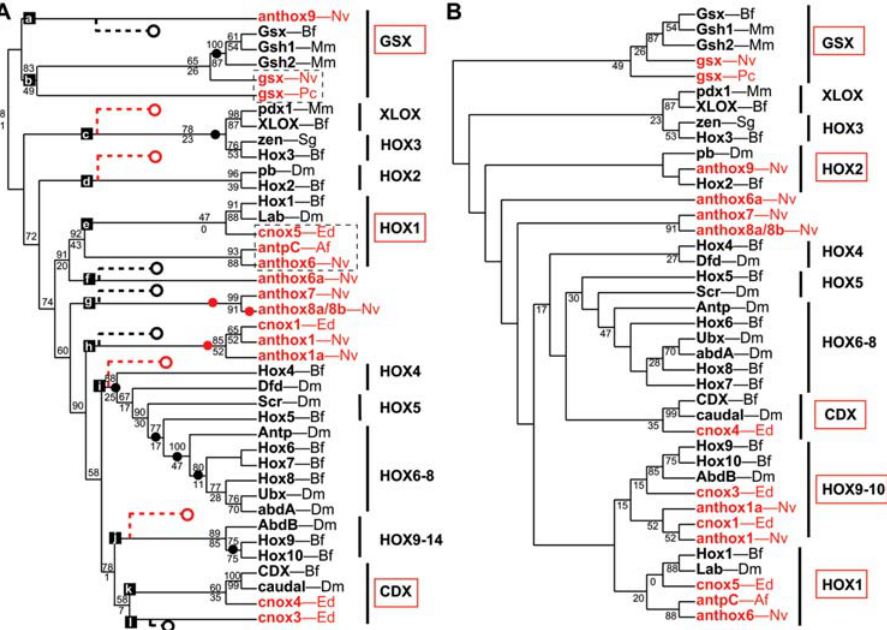
Figure 9. Re-analysis of the Kamm et al. maximum-likelihood phylogeny. (A) The redrawn maximum-likelihood phylogeny presented by Kamm et al. [49]. The tree is unrooted. Based on the Dayhoff-PAM1 substitution matrix [129] the tree’s overall likelihood is 2 2288.08809. Bootstrap proportions determined in the original study are shown above the relevant nodes. Bootstrap proportions determined in the current study are shown below the relevant nodes. Inferred lineage specific gene losses are represented by open circles (black for Bilateria and red for Cnidaria). Inferred lineage specific gene duplications are represented by solid circles (black for Bilateria and red for Cnidaria). Sequences inferred to have been present in the common ancestor are indicated by lettered squares. The names of gene families that contain cnidarian representatives are enclosed by red lines. (B) A tree we identified using global instead of local rearrangements with the Kamm et al. data and the Dayhoff substitution matrix. The tree’s overall likelihood is 2 2280.76406. Bootstrap proportions determined in the present study are shown below the relevant nodes. The dataset used in this analysis is available as Figure S13.